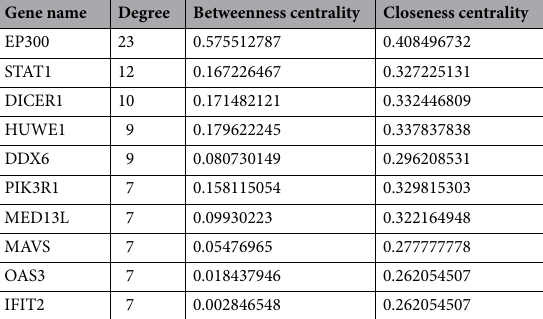
Genes Predicted partner gene Total score Gene co-expression score Network topology